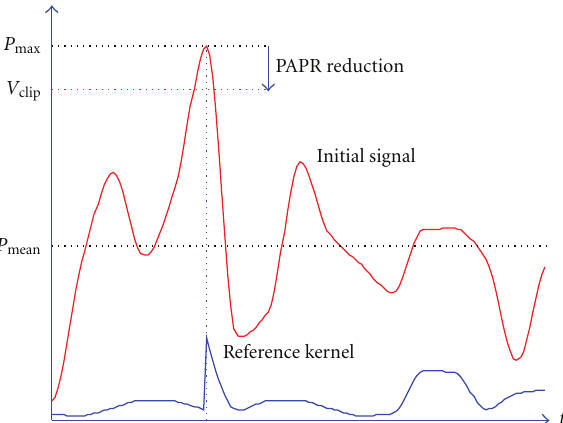
Figure 2: Principle of peak suppression by reference kernel signal.